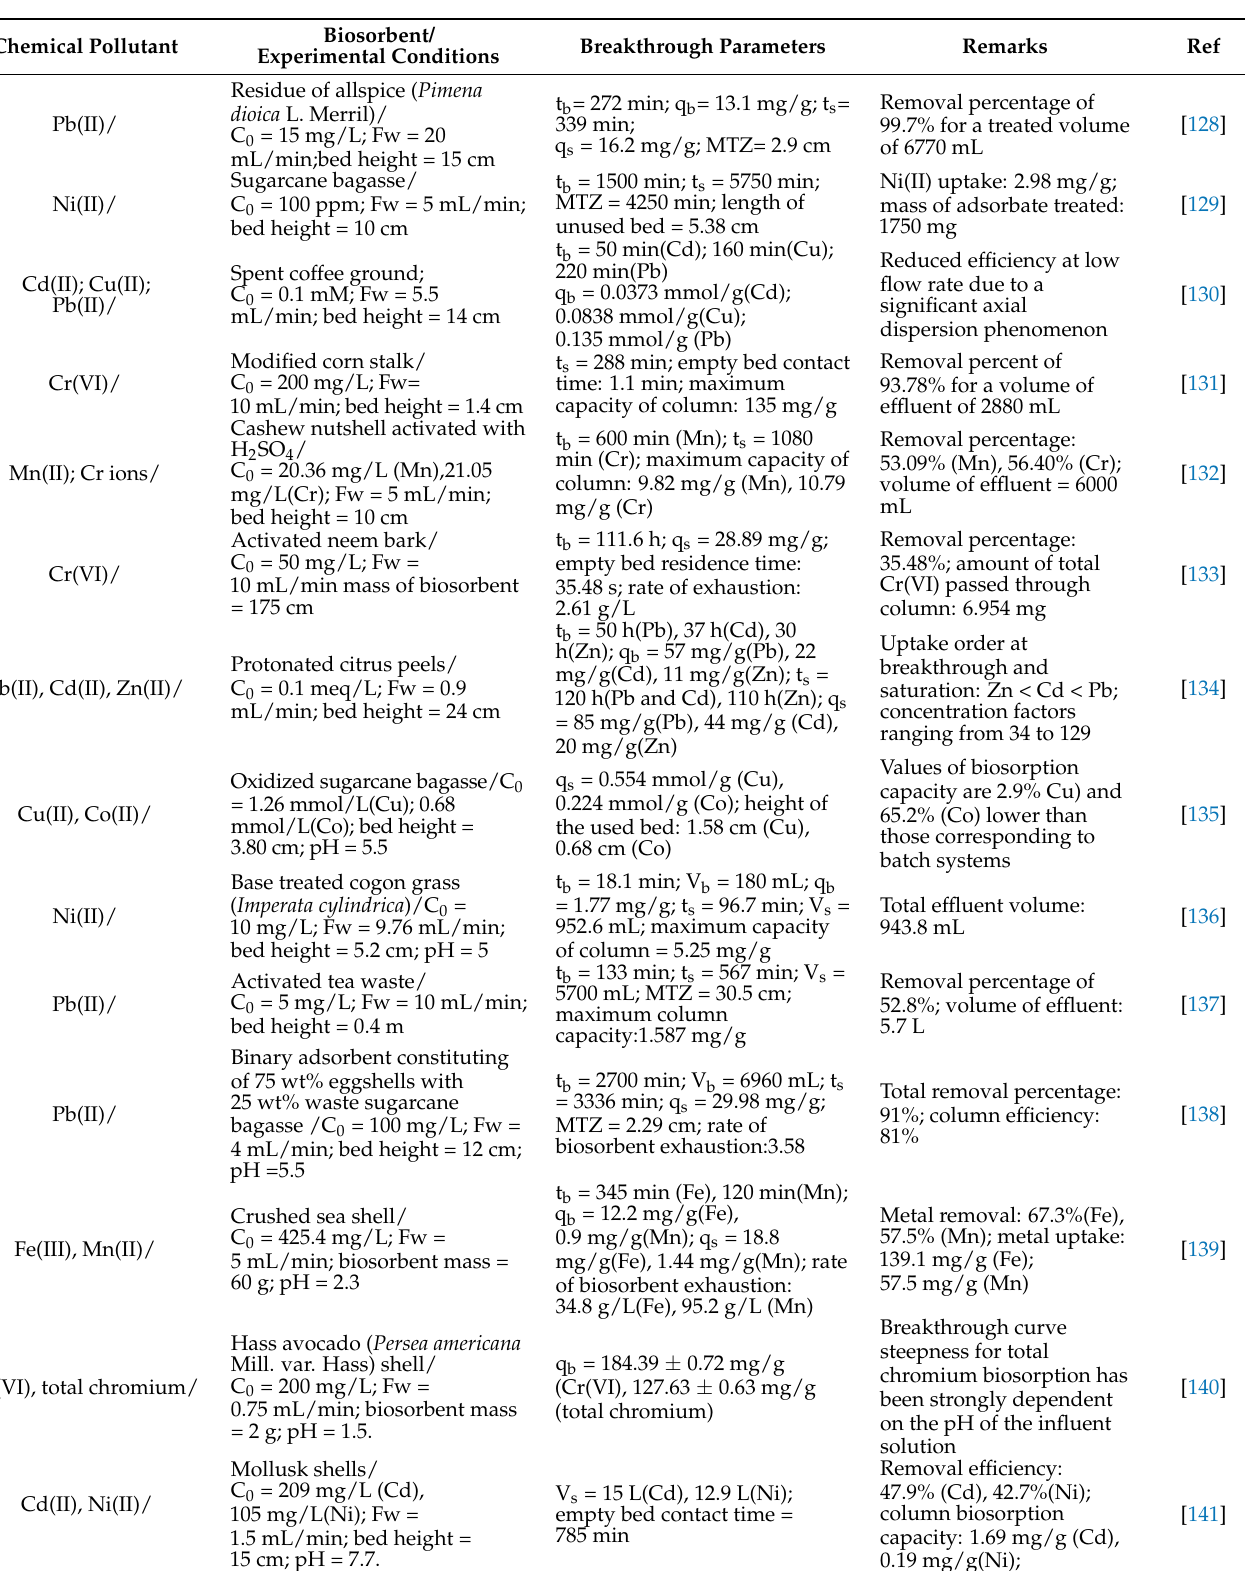
Table 1. Characterization of dynamic biosorption systems for inorganic and organic pollutant removal via the parameters of breakthrough